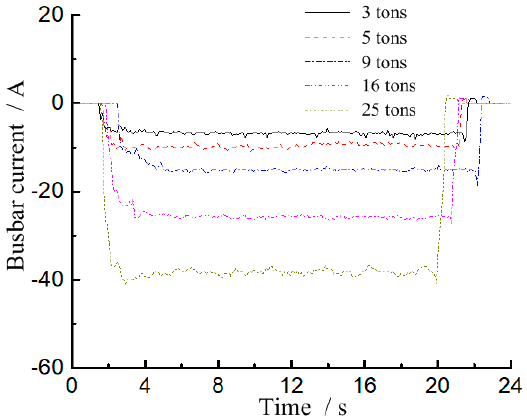
Figure 17. Generating current under different loads.